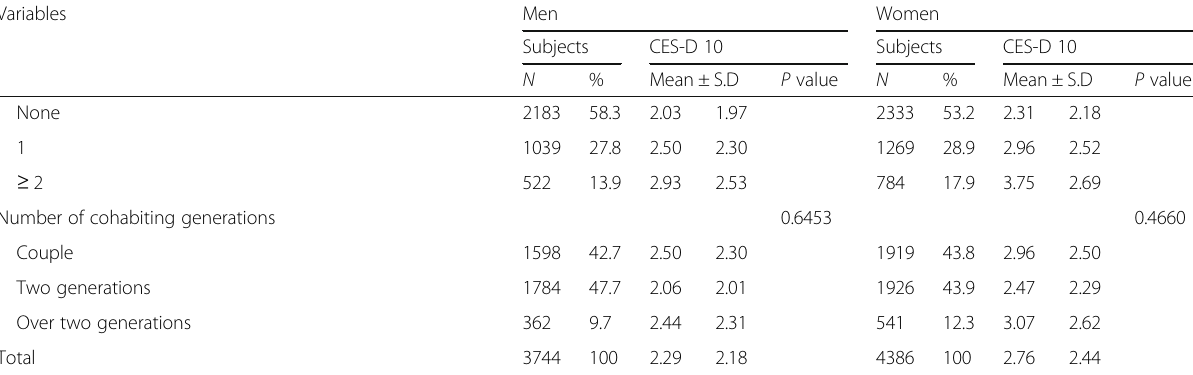
Table 1 Baseline characteristics of the study population by CES-D 10 (Continued)